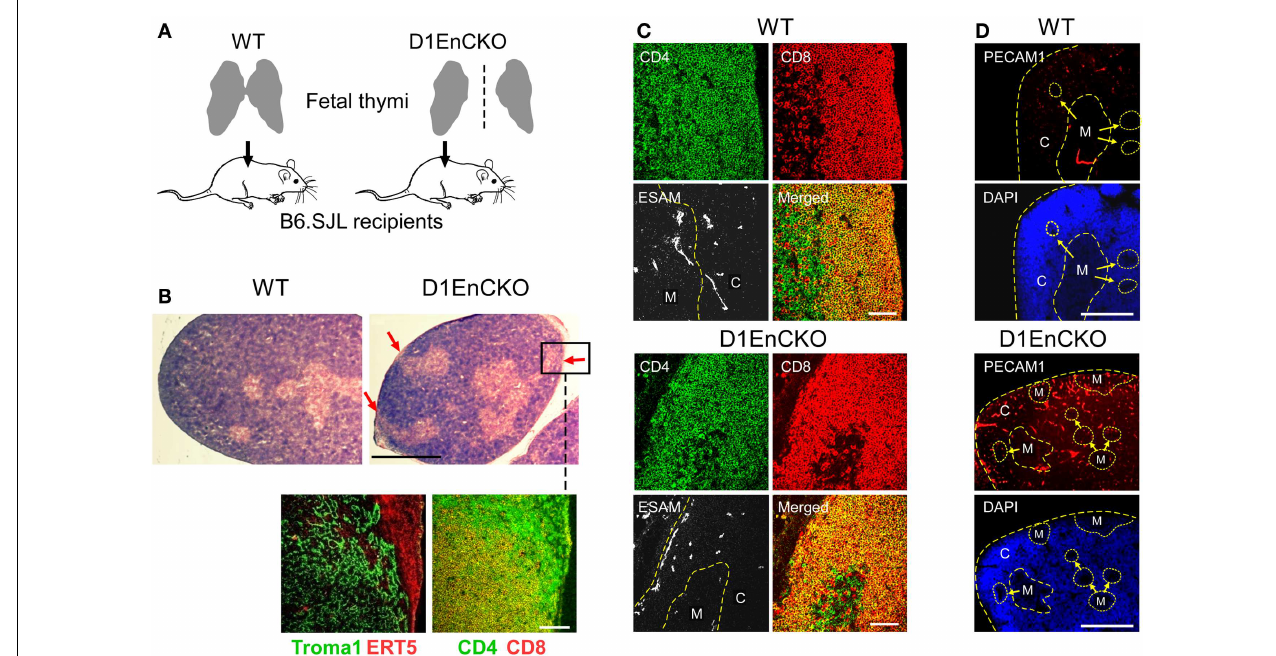
the subcapsular region. Result is representative of three independent transplantation experiments.White bar in the confocal image represents 100 µ m and in the H&E stained image represents 5mm. (C) Cryosections ofWT and D1EnCKO thymus were stained with anti-CD4-APC, anti-CD8 α -TRITC, and anti-ESAM mAb-FITC. Dashed yellow line follows the corticomedullary junction; in the D1EnCKO panel, a second dashed yellow line to the left indicates the ESAM + cells in the subcapsullar zone. C, cortex; M, medulla. Result is representative of three independent transplantation experiments.White bar in the merged images are 100 µ m. (D) Pecam1 staining to identify developing vascular endothelial structures. High density nuclear staining by DAPI delineates cortical regions and lower density nuclear staining correlates with medullary structures. C, cortex; M, medulla.The corticomedullary junctions and capsules are identified by dashed yellow lines.White bar in the images is